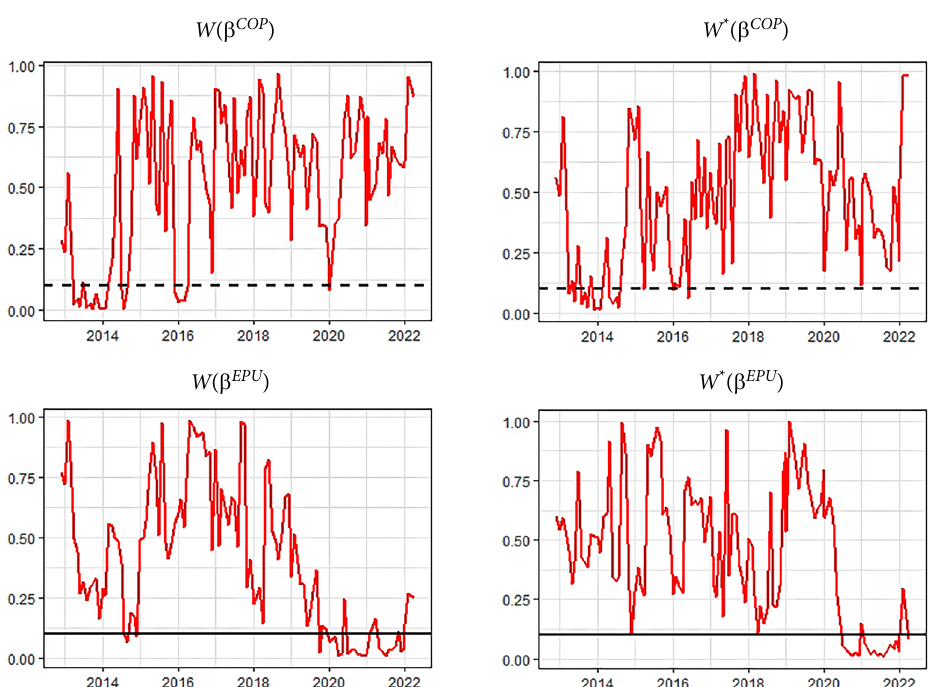
Figure 4. Wald tests of constancy of rolling quantile parameter